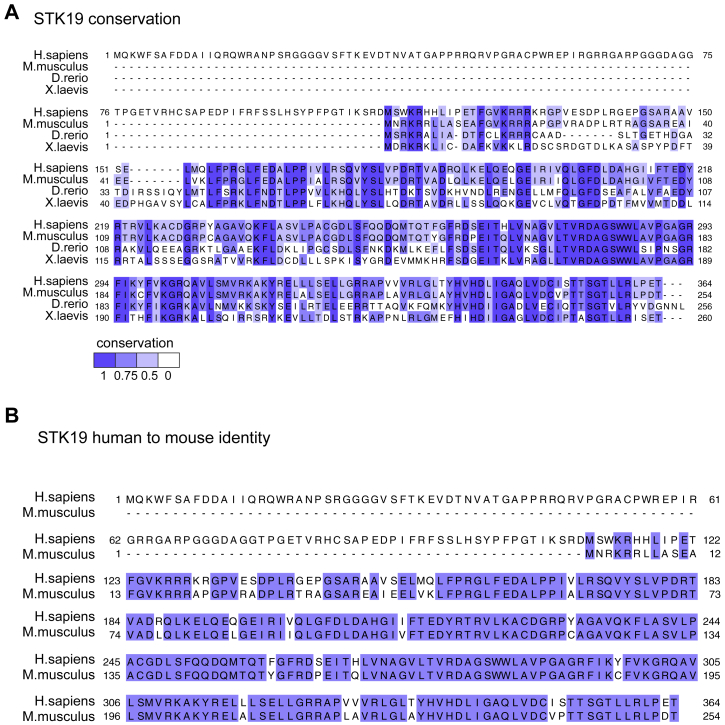
STK19 Protein Conservation, Related to Figure 1(A) Alignment of the presently annotated STK19 protein from four different metazoans. Conservation ratio is shown as shades of purple as indicated in the legend below. (B) Alignment of mouse (Mus musculus) and the presently annotated human (Homo sapiens) STK19 proteins. Purple indicates identical residues.